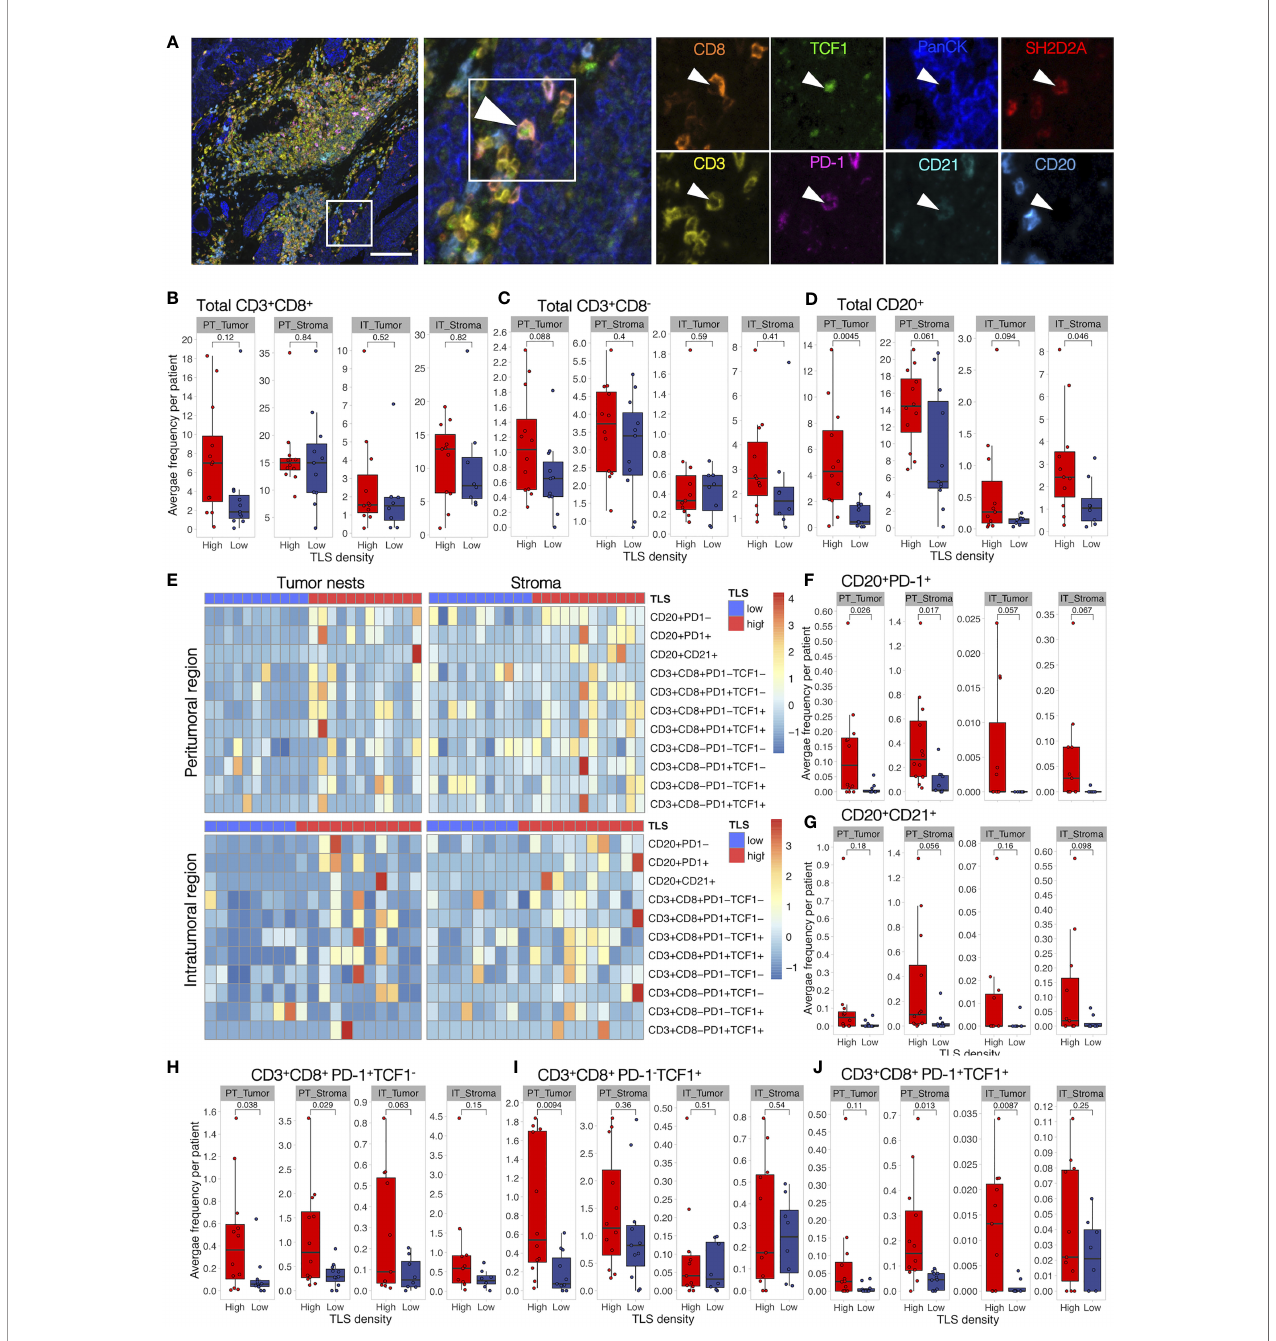
FIGURE 5 | Activated B cells and progenitor-like T cells are increased in TLS-high tumors. Characterization of immune cell phenotypes in TME was performed by mIF staining of CD20 (B cells), CD21 (FDCs), CD3 (total T cells), CD8 (cytotoxic T cells), PD-1 (activation marker), TCF1 (marker of naïve cells), SH2D2A (T cell- speci fi c adaptor protein), and PanCK (tumor cells). Images were acquired by multispectral microscopy from a representative set of peritumoral (PT) and intratumoral (IT) regions. Per-cell fl uorescent data were obtained by cell segmentation in tumor nests and stromal regions. (A) A representative image of a TLS-high tumor and corresponding mIF staining identifying PD-1 + TCF1 + (progenitor-like) CD8 + T cell in fi ltrating a tumor nest. Scale bar = 100 m m. (B – D) Total CD8 + (B) and CD8 - T-cell (C) and B-cell (D) frequencies were measured as the proportion of all cells within the respective tissue categories (tumor or stroma) and averaged per patient in peritumoral (PT) and intratumoral (IT) regions. In fi ltration in the two d-TLS density groups was compared by two-tailed t -test. No correction for multiple testing was done. (E) Heatmaps displaying z-scaled average frequencies of each measured subpopulation in each tissue category (tumor or stroma) in peritumoral and intratumoral regions for all analyzed patients. (F – J) Frequencies of PD-1 + (E) and CD21 + (G) B cells, PD-1 + TCF1 - (H) , PD-1 - TCF1 + (I) , as well as PD-1 + TCF1 + (J) CD8 + T cells were quanti fi ed and compared as described in (B)